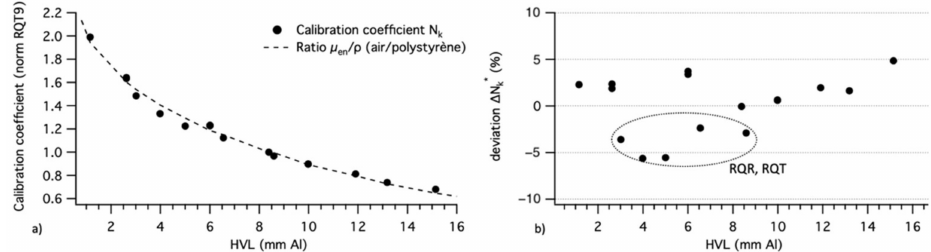
Figure 5. ( a ) Calibration coefficient N k , Q ∗ of IVISCAN ® (dots) and mass–energy-absorption coefficient ratio for air and polystyrene (line), normalized to RQT9 radiation quality for the entire diagnostic radiology energy range. ( b ) Deviation between IVISCAN ® and theoretical model for the entire diagnostic radiology energy range. Dotted circle shows the deviation for RQR and RQT radiation